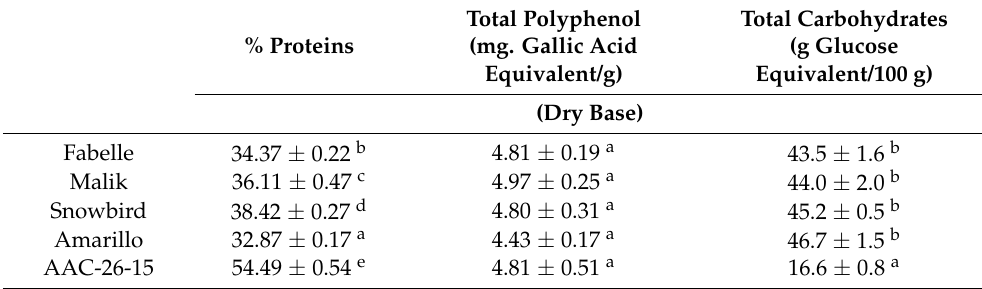
Table 2. Composition analysis of the 3 kDa permeate of legume